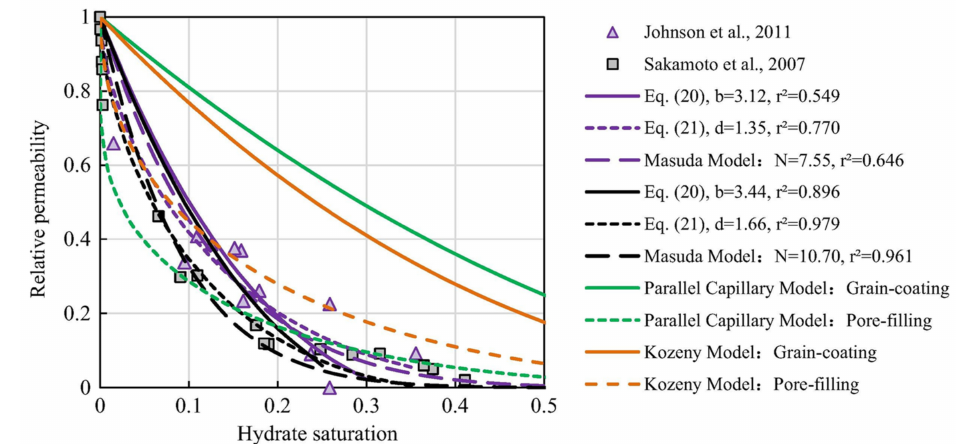
Figure 25. Comparison of experiment results [89,93] and calculation results from reported permeabil- ity models [23,42] reprinted from [63] with permission from